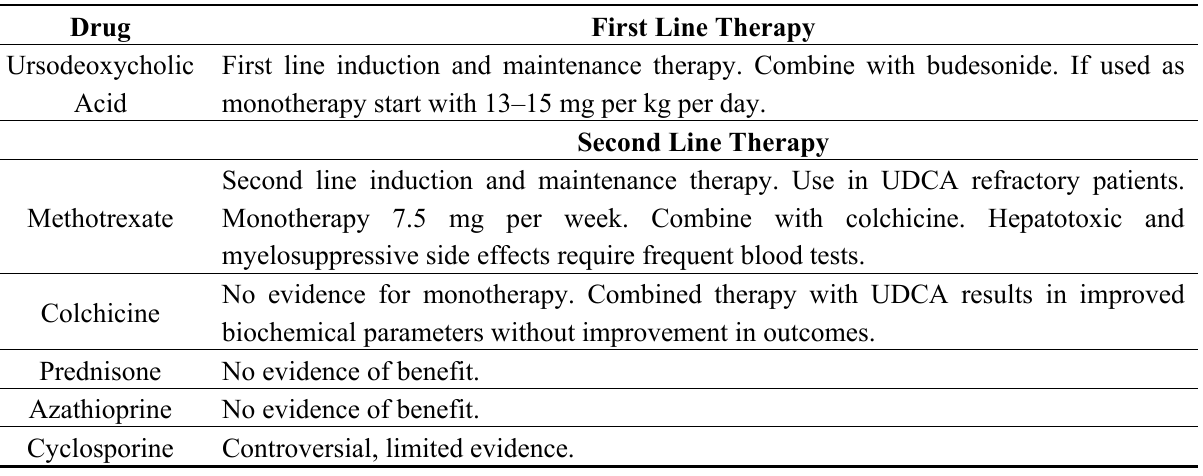
Table 2. Immunosuppressive Pharmacotherapy—Primary Biliary